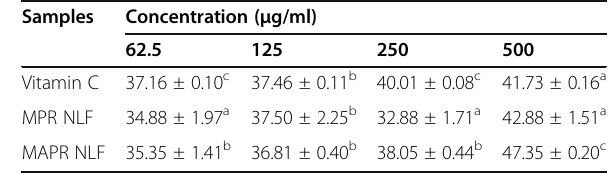
Table 3 Inhibition of lipid peroxidation of methanol and methanol/acetone phenolic-rich extracts of